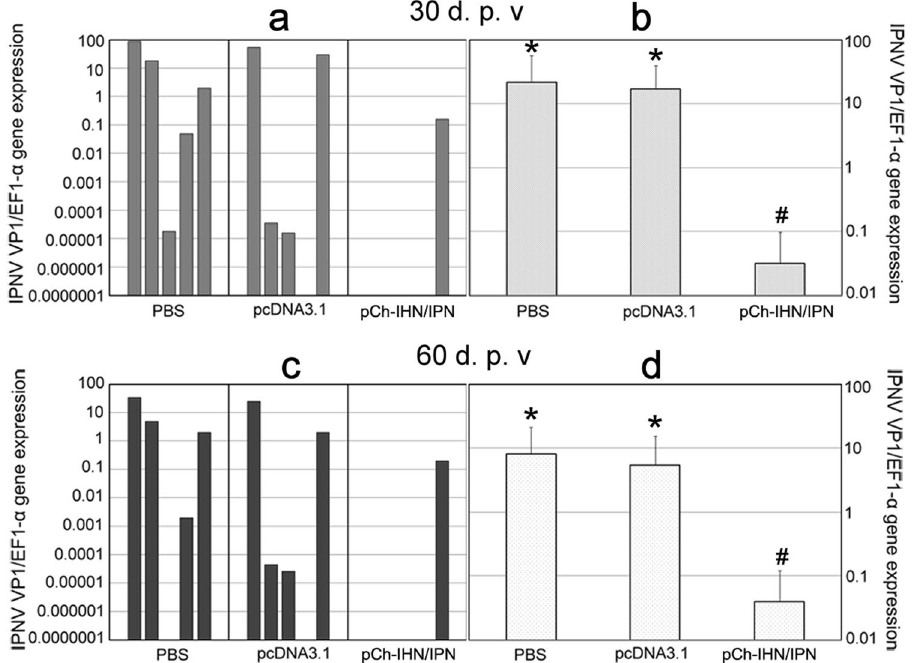
Figure 3. Quantitative reverse transcription–PCR determination of IPNV load using VP1 gene expression in the anterior kidneys of vaccinated rainbow trout (n = 5) challenged with IPNV strain ChRtm213 at 30 or 60 d.p.v. IPNV loads were measured at 15 days post challenge. Rainbow trout injected with plasmid pcDNA3.1 alone or with PBS were used as the negative controls. EF- α was used to normalize the expression of the IPNV VP1 gene. Individual VP1 gene expression levels ( a , c ) and average expression levels ( b , d ) are shown separately. Differences were analysed, and different symbols above the bars indicate significant differences (P <